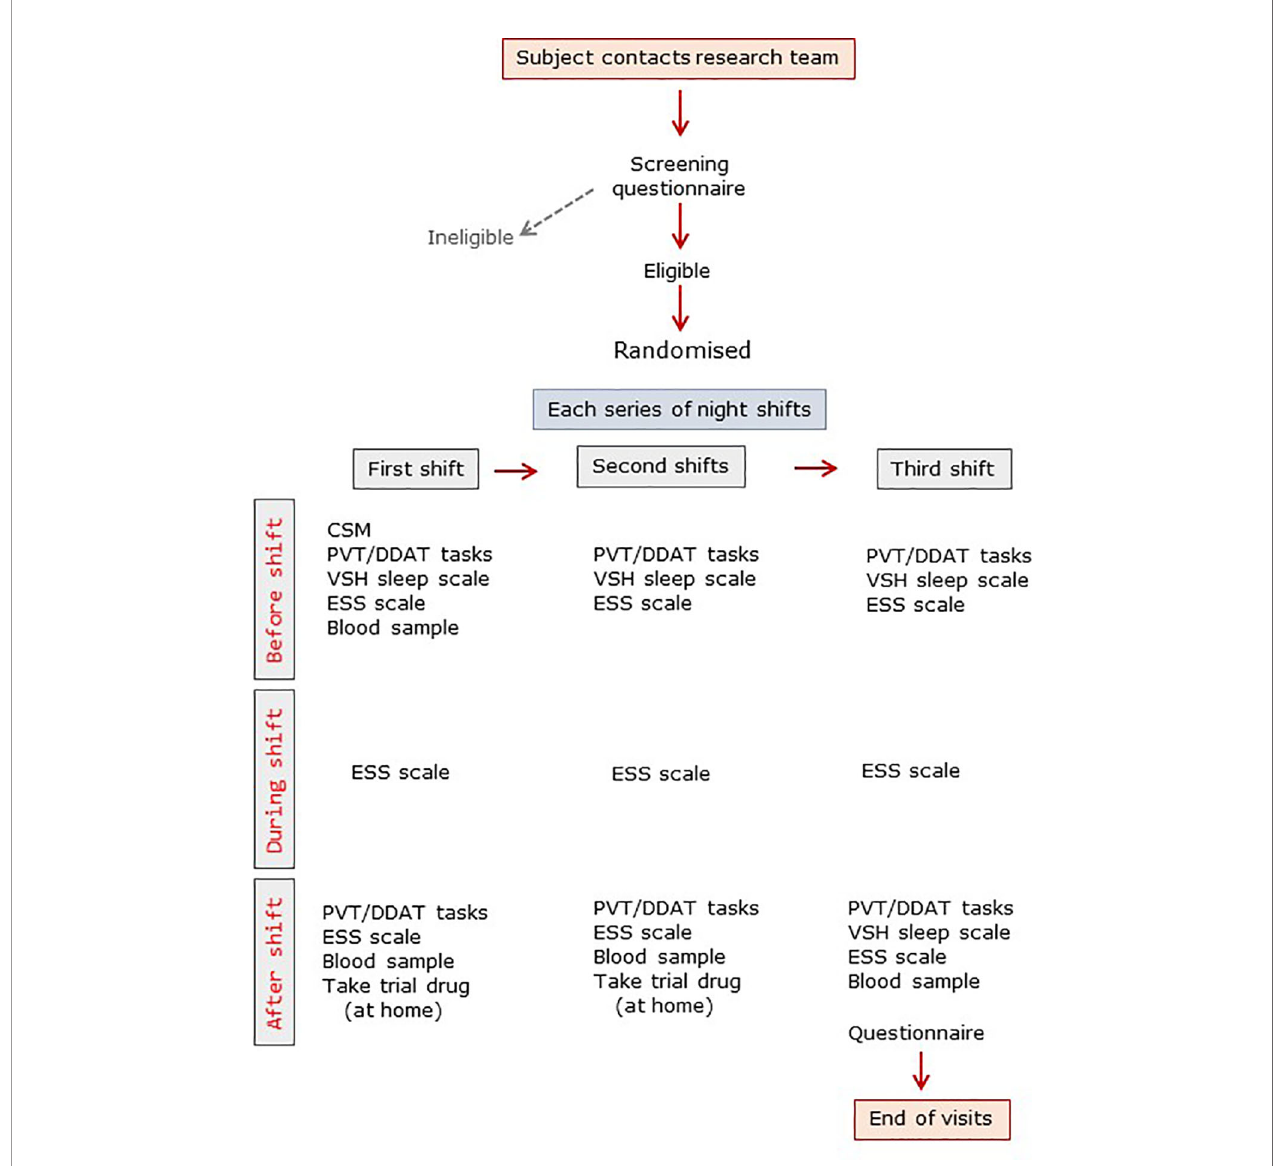
FIGURE 1 | Trial visit summary. ESS, Epworth sleepiness score; CSM, composite scale of morningness; DDAT, double digit addition task; PVT, psychomotor vigilance task; VSH, Verran-Snyder-Halpern sleep